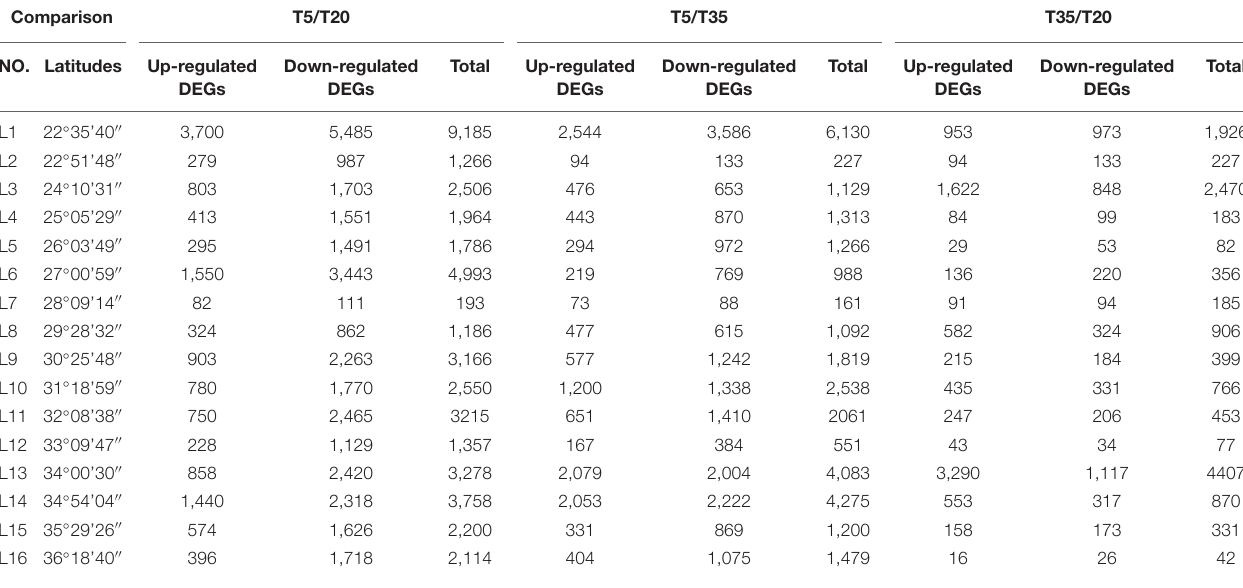
TABLE 1 | The up/downregulated differentially expressed genes (DEGs) in 16 latitudes among three comparisons. Comparison